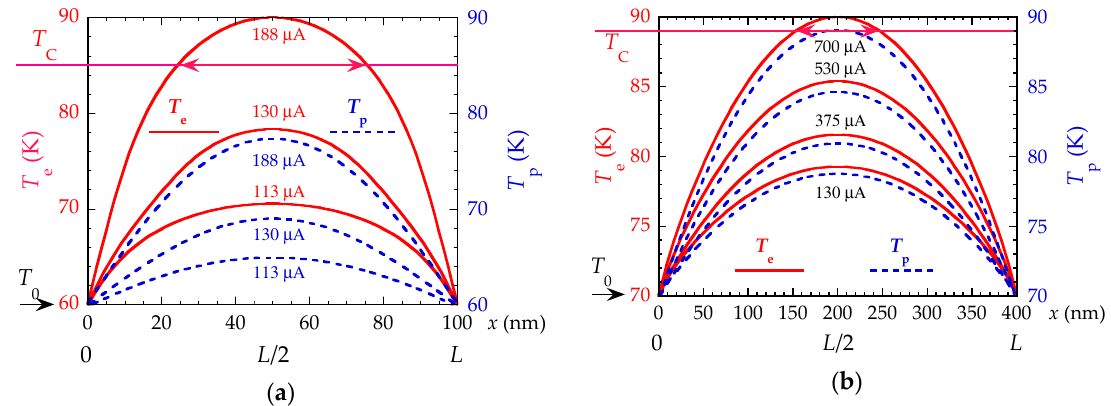
Figure 4. For devices A and B, electron temperature T e ( x ) (solid curves) and phonon temperature T p ( x ) (dashed curves) profiles: ( a ) For device A ( P LO = 5 μ W); ( b ) for device B ( P LO = 35 μ W). T 0 and T C are the reference (cold finger) and mid-transition critical temperatures, respectively. Arrows on T C lines delimit the hot spot regions Δ x HS (see text). Curve labels indicate the DC bias current I 0 values.